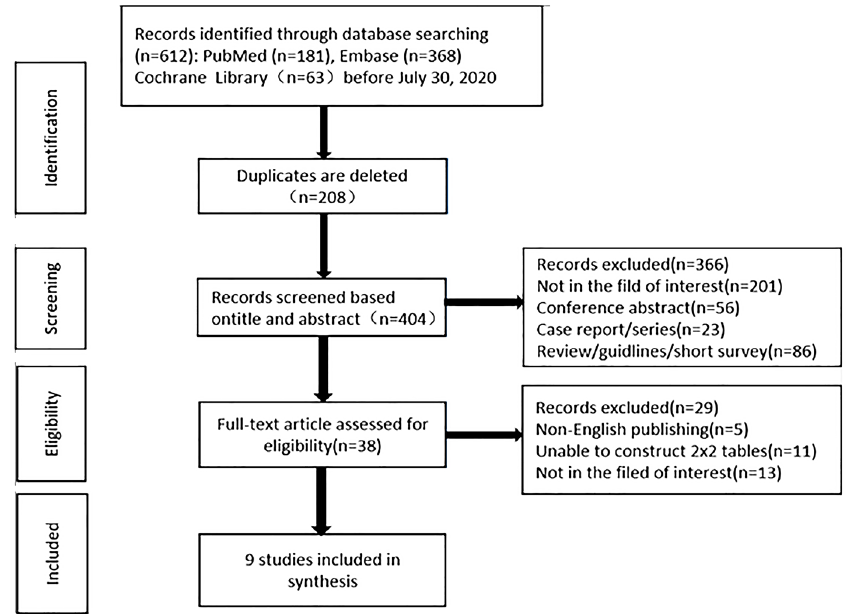
Figure 1 - The literature screening flow chart of the inclusion